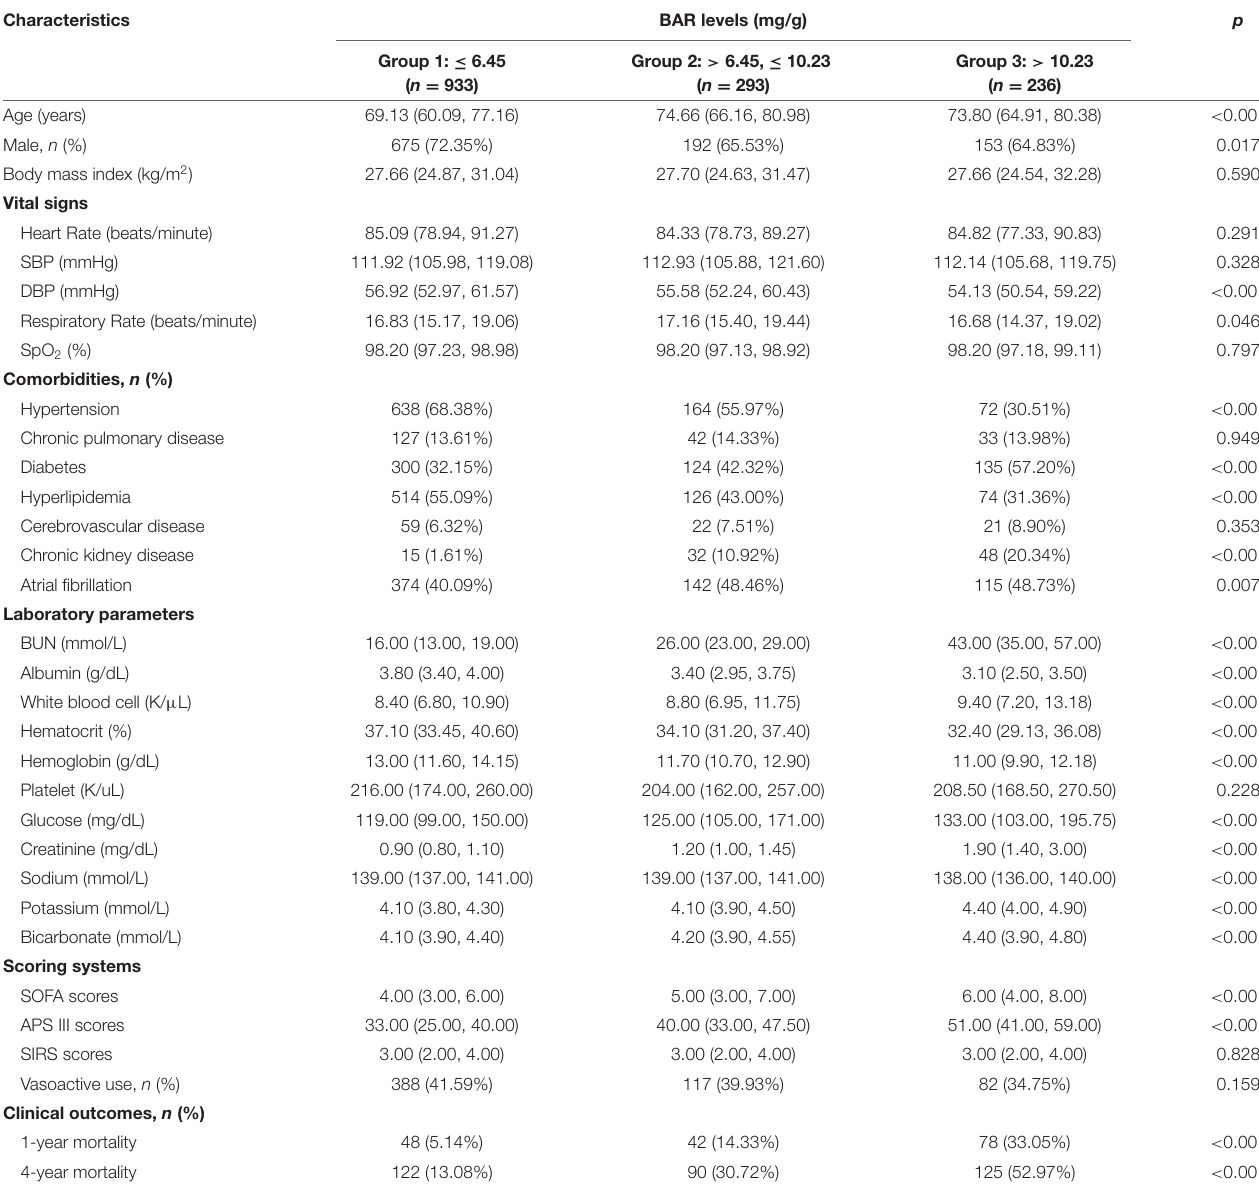
TABLE 2 | Clinical characteristics of patients classified by BAR.